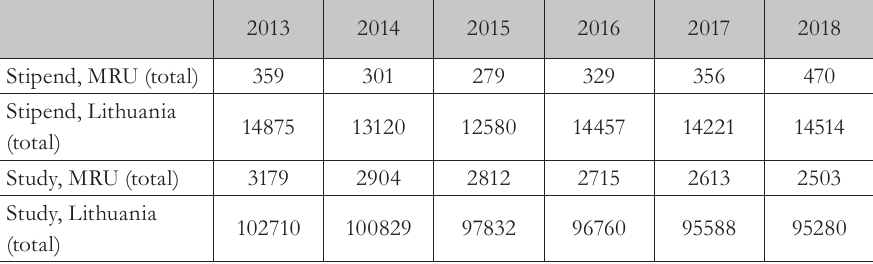
Fig. 4 – Dynamics of Lithuanian state budget appropriations for studies (MRU) and dynamics of the number of students (MRU). Source: Statistics Lithuania, 2019; Mykolas Romeris University, 2019 Particularly noticeable are the differences in the budget appropriations for stipends in other Lithuanian universities and MRU (Table 1 and Figure 5). Tab. 1 – Lithuanian state budget appropriations in thousands of EUR. Source: Statistics Lithua- nia (2019); Mykolas Romeris University